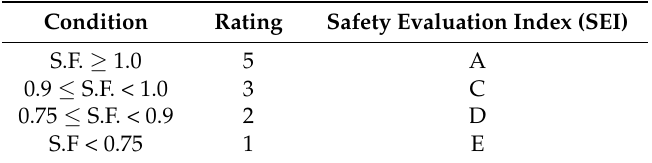
Table 7. Total safety evaluation index (SEI) for the cloud computing-based pier type port structure stability evaluation